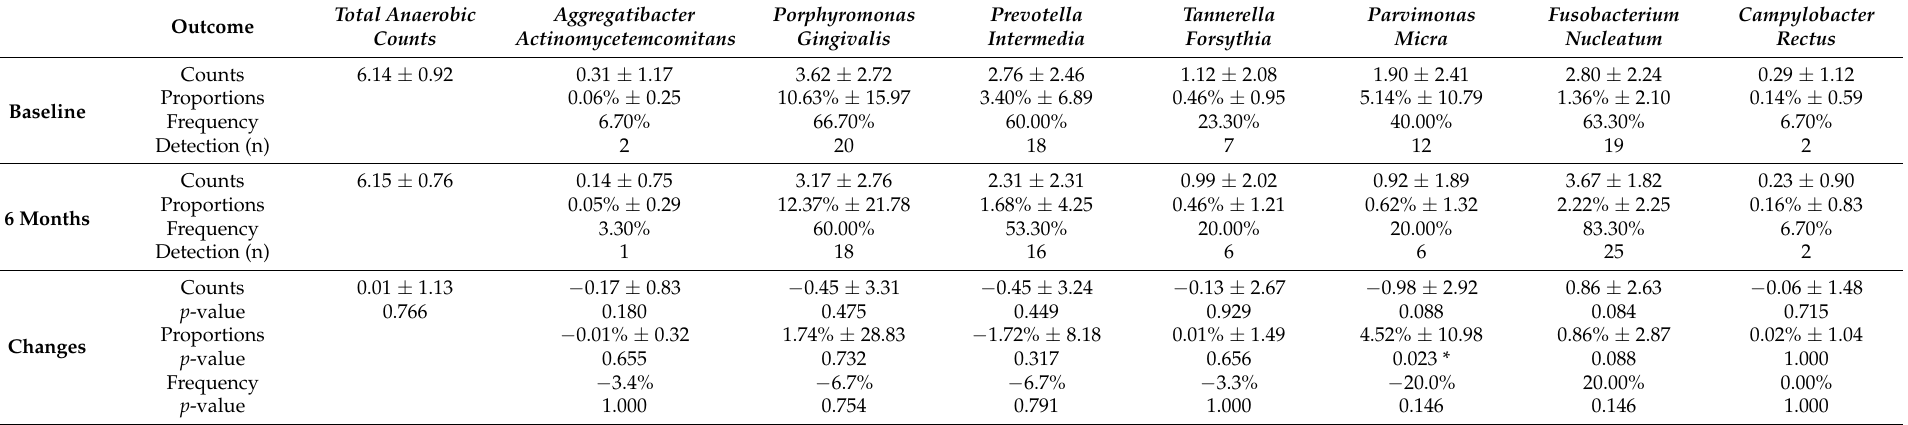
Table 4. Mean counts and proportions (expressed as mean ± standard deviation) and frequency of detection of target bacterial species, with the number of positive samples at baseline and at 6 months.